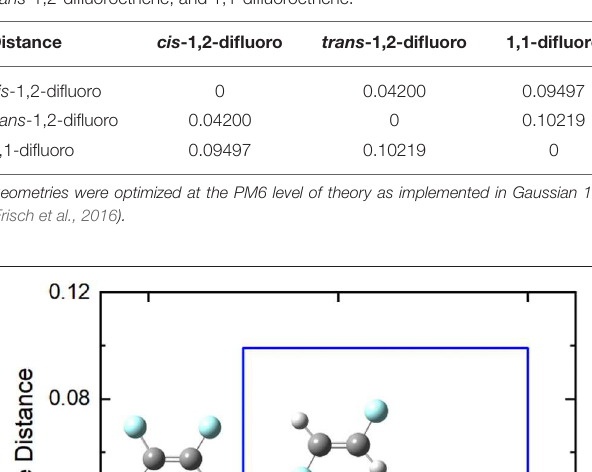
TABLE 1 | The cosine distance matrix for cis -1,2-difluoroethene, trans -1,2-difluoroethene, and 1,1-difluoroethene.